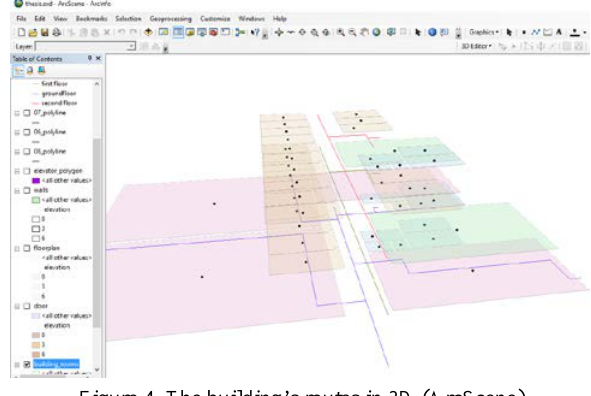
Figure 4. The building’s routes in 3D (ArcScene)